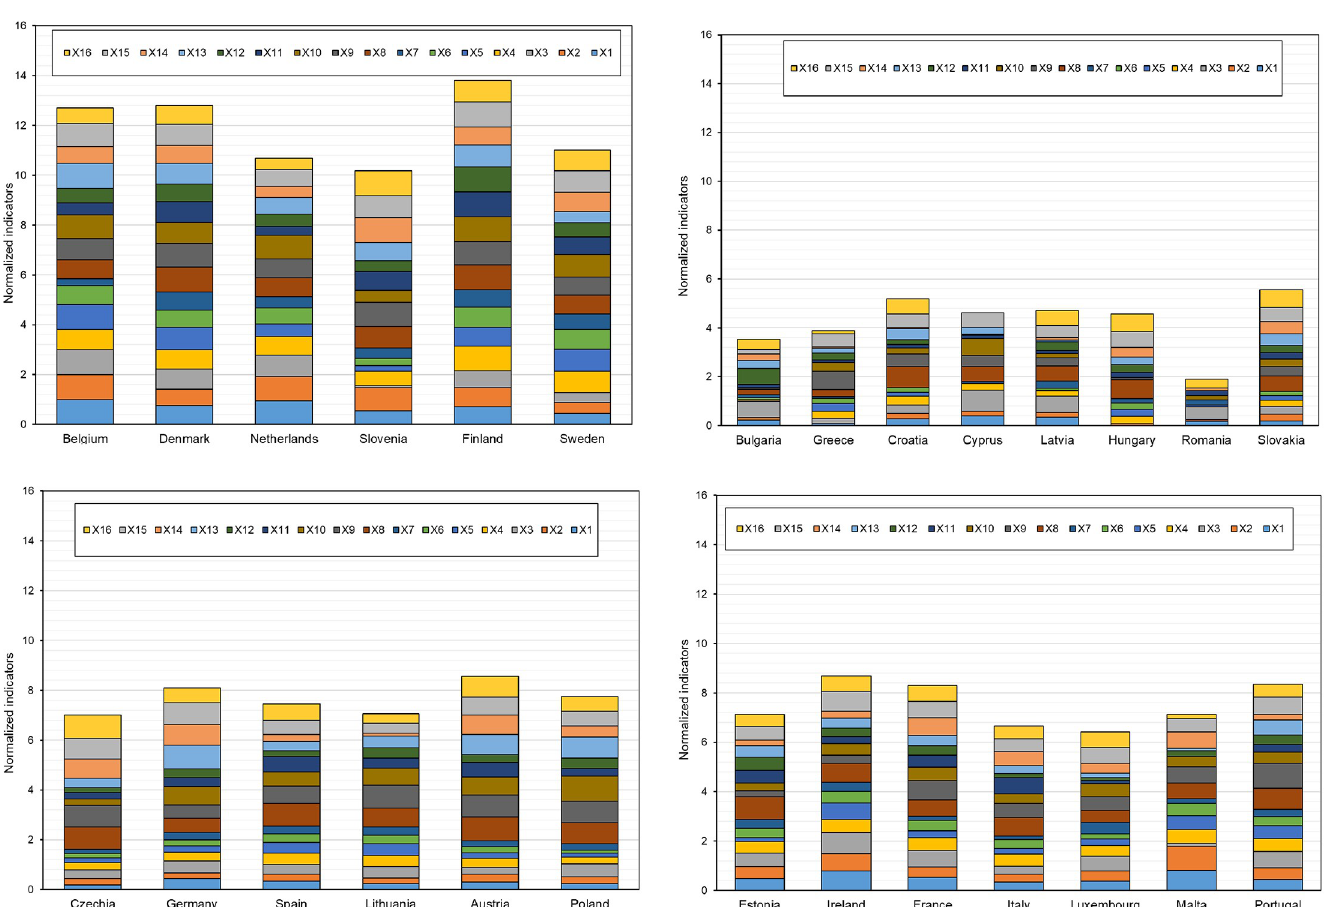
Fig 12. The summary of studied indicators on digitalization and robotization of large enterprises for EU countries in the designated similar groups (a-cluster 1, b- cluster 2, c-cluster 3, d-cluster 4).